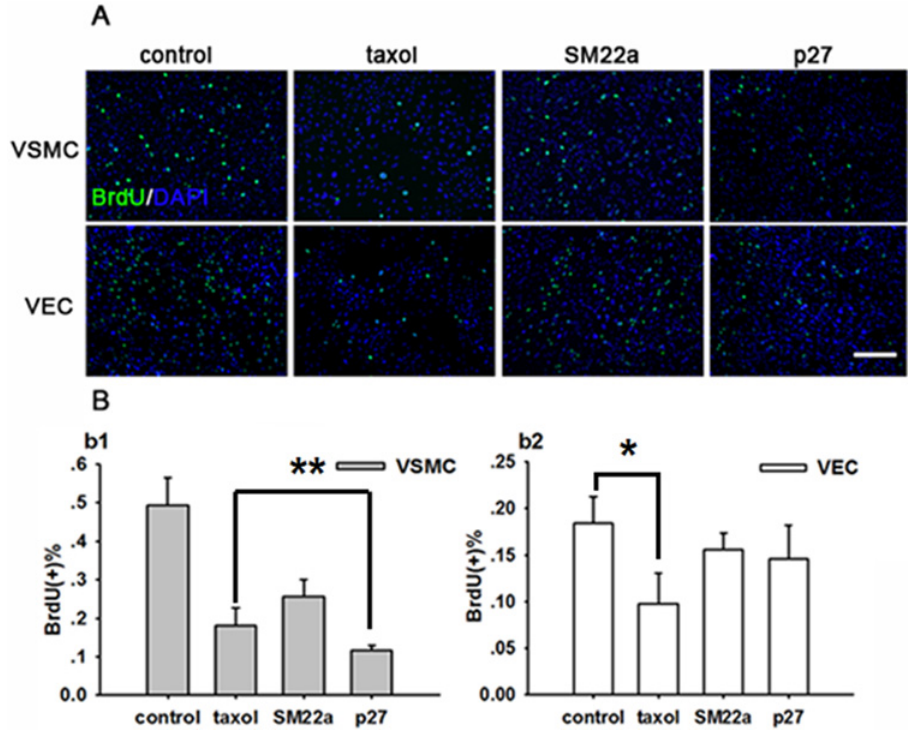
Fig 2. Targeted inhibition of VSMC proliferation in vitro by Lenti-SM22alpha-p27 vectors compared with paclitaxel. A. BrDU immunofluorescence staining of BrdU in VSMCs and VECs (control, taxol, SM22a and p27 groups). BrdU is shown in green and DAPI is shown in blue. Scale bar: 200 μ m. B. BrdU positive cells in VSMCs (b1) and VECs (b2). * (p < 0.05, taxol vs. control). ** (p < 0.05, taxol vs. p27). Error bars represent the mean ± S.E. (n =